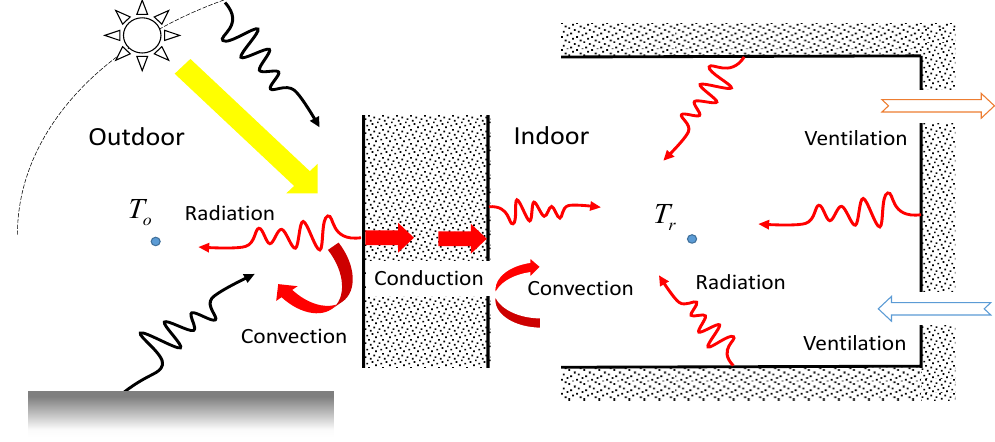
Figure 1. Built environmental